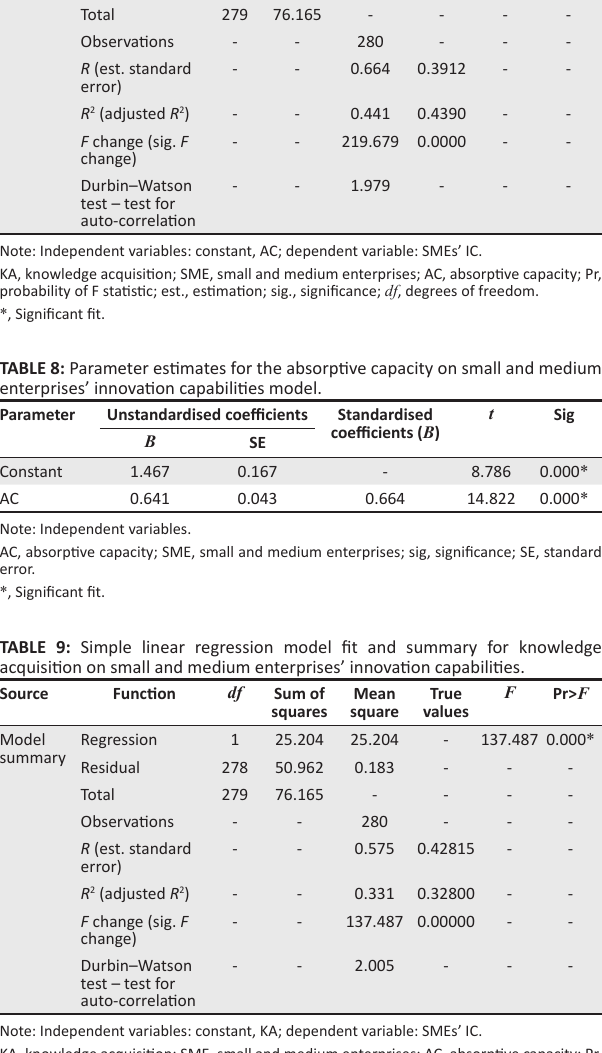
TABLE 5: Simple linear regression model fit and summary for knowledge sharing on small and medium enterprises’ absorptive capacity. Source Function Model Regression summary